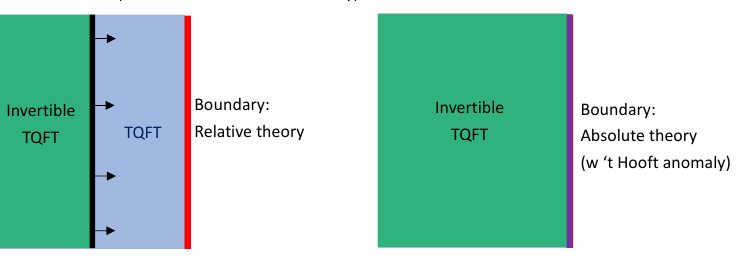
Figure 4 . An absolute theory can be constructed from a domain wall separating the original bulk and an invertible TQFT, after colliding it with the